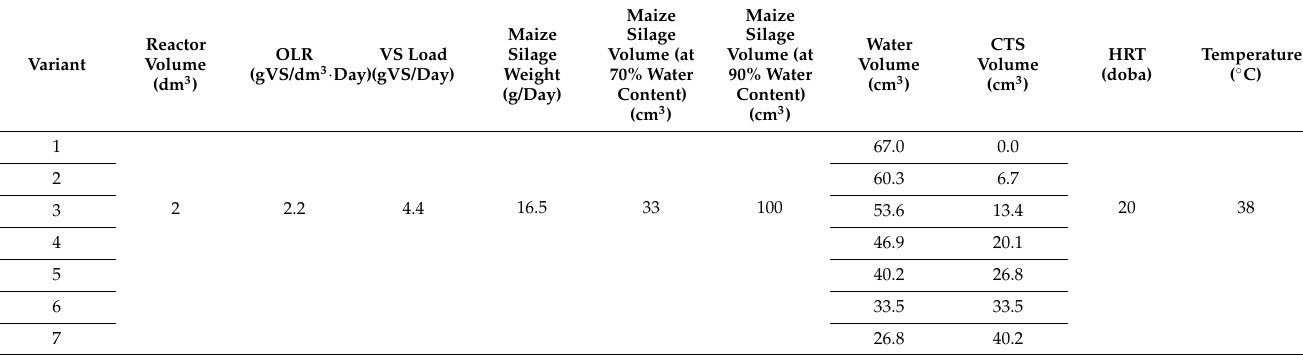
Table 3. Feedstock volumes and key process